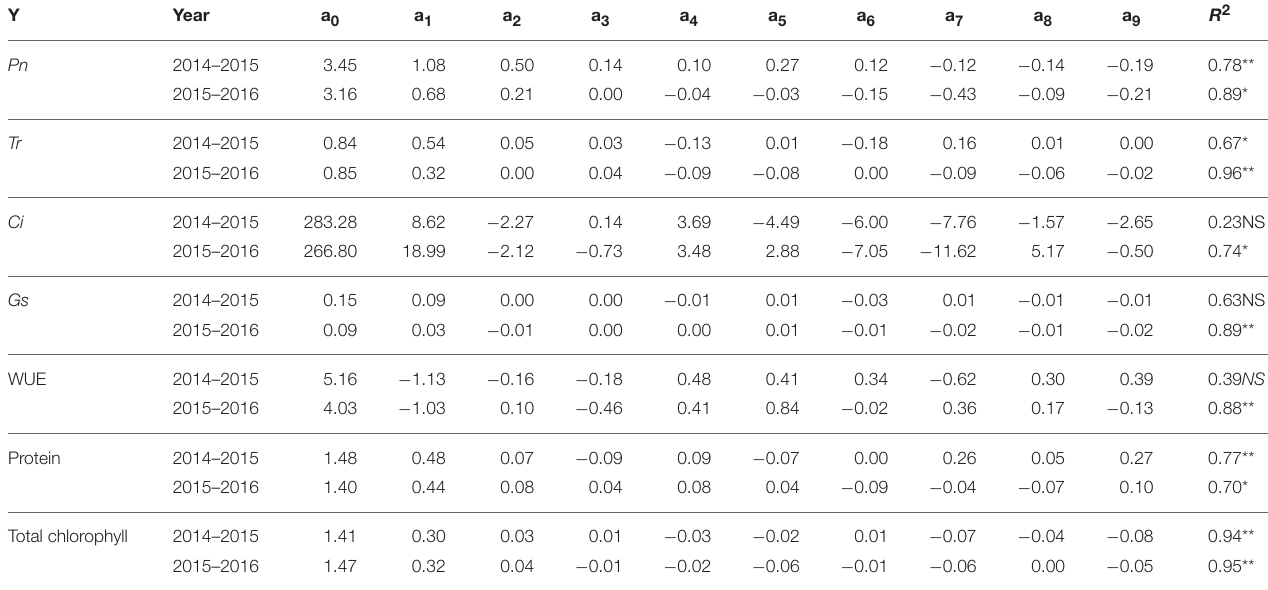
TABLE 6 | Parameter coefficients of the regression equation ( Y = a 0 + a 1 x 1 + a 2 x 2 + a 3 x 2 + a 4 x 1 x 2 + a 5 x 1 x 3 + a 6 x 2 x 3 + a 7 x 2 1 + a 8 x 2 2 + a 9 x 2 3 ) for photosynthesis ( Pn ), transpiration ( Tr ), inter cellular CO 2 concentration ( Ci ), stomal conductance ( Gs ), water use efficiency (WUE), protein levels and total chlorophyll during the first experiment (2014–2015) and the second experiment (2015–2016). x 1 , x 2, x 3 are the coded values of the fertilizer rates for N, P, and